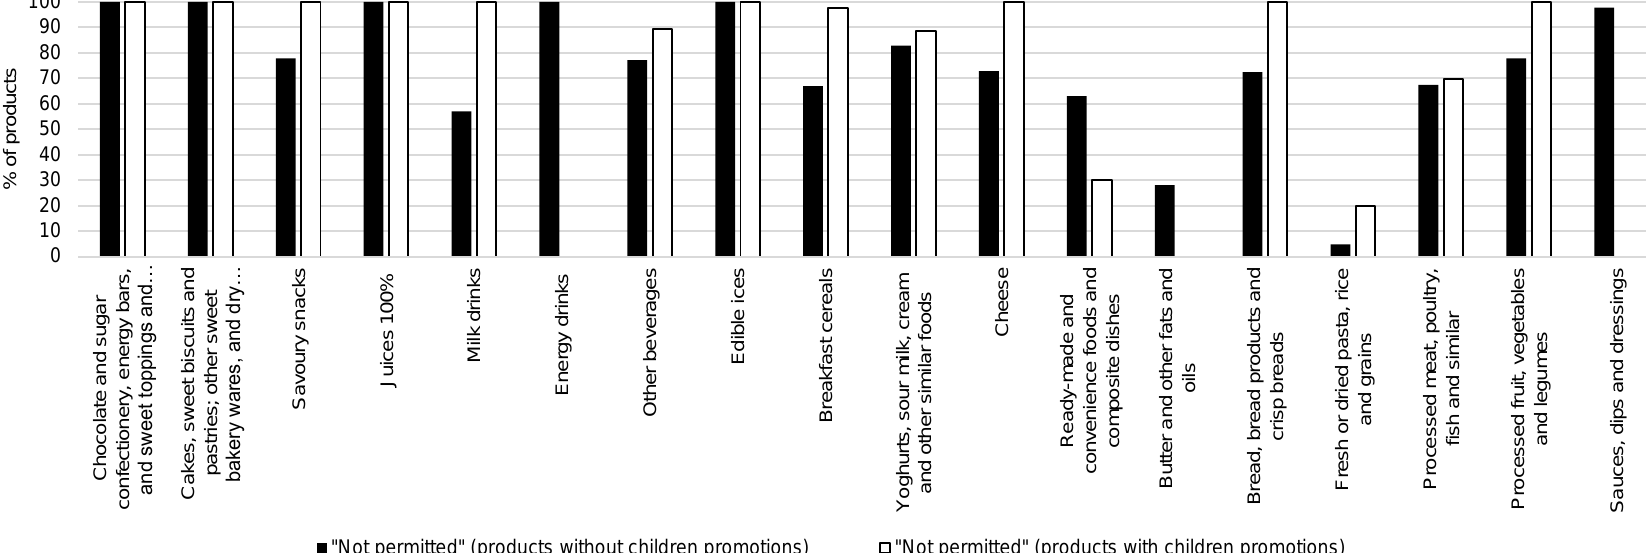
Figure 1. Proportion of products, scored as “not permitted” (by the World Health Organization Regional Office for Europe nutrient profile model) in specific food categories for products without children promotions ( (cid:4) black bars) and for products with children promotions ( (cid:3) white bars).